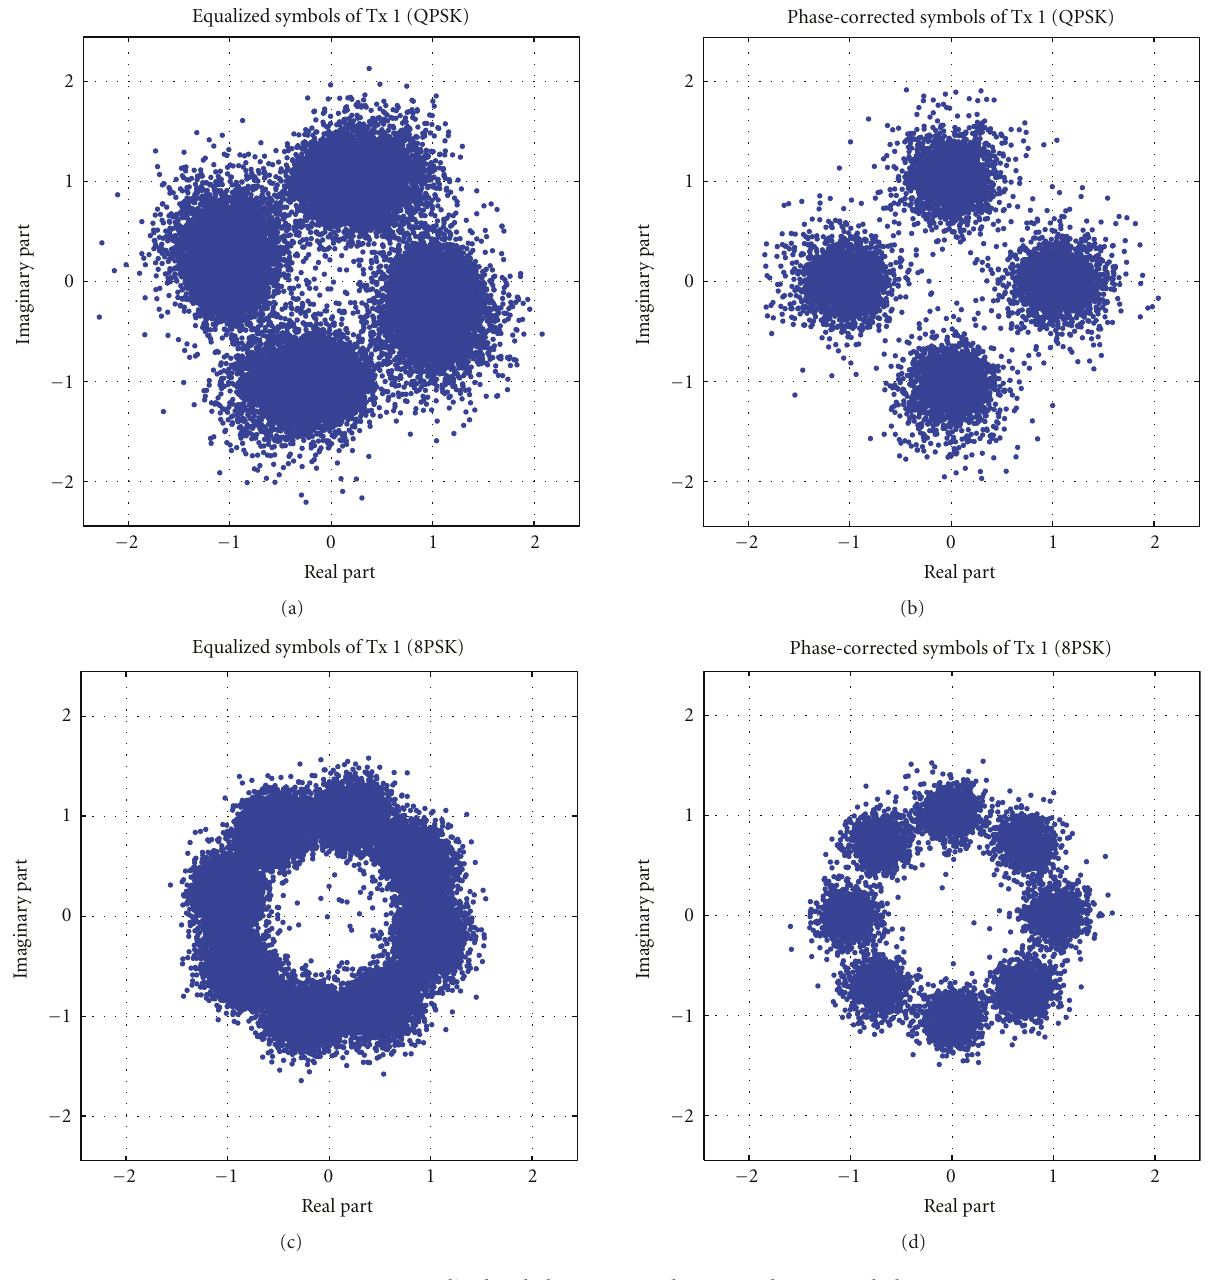
Figure 10: Equalized and phase-corrected QPSK and 8PSK symbols. Table 4: BER of HB 2 × 8 MIMO with BPSK